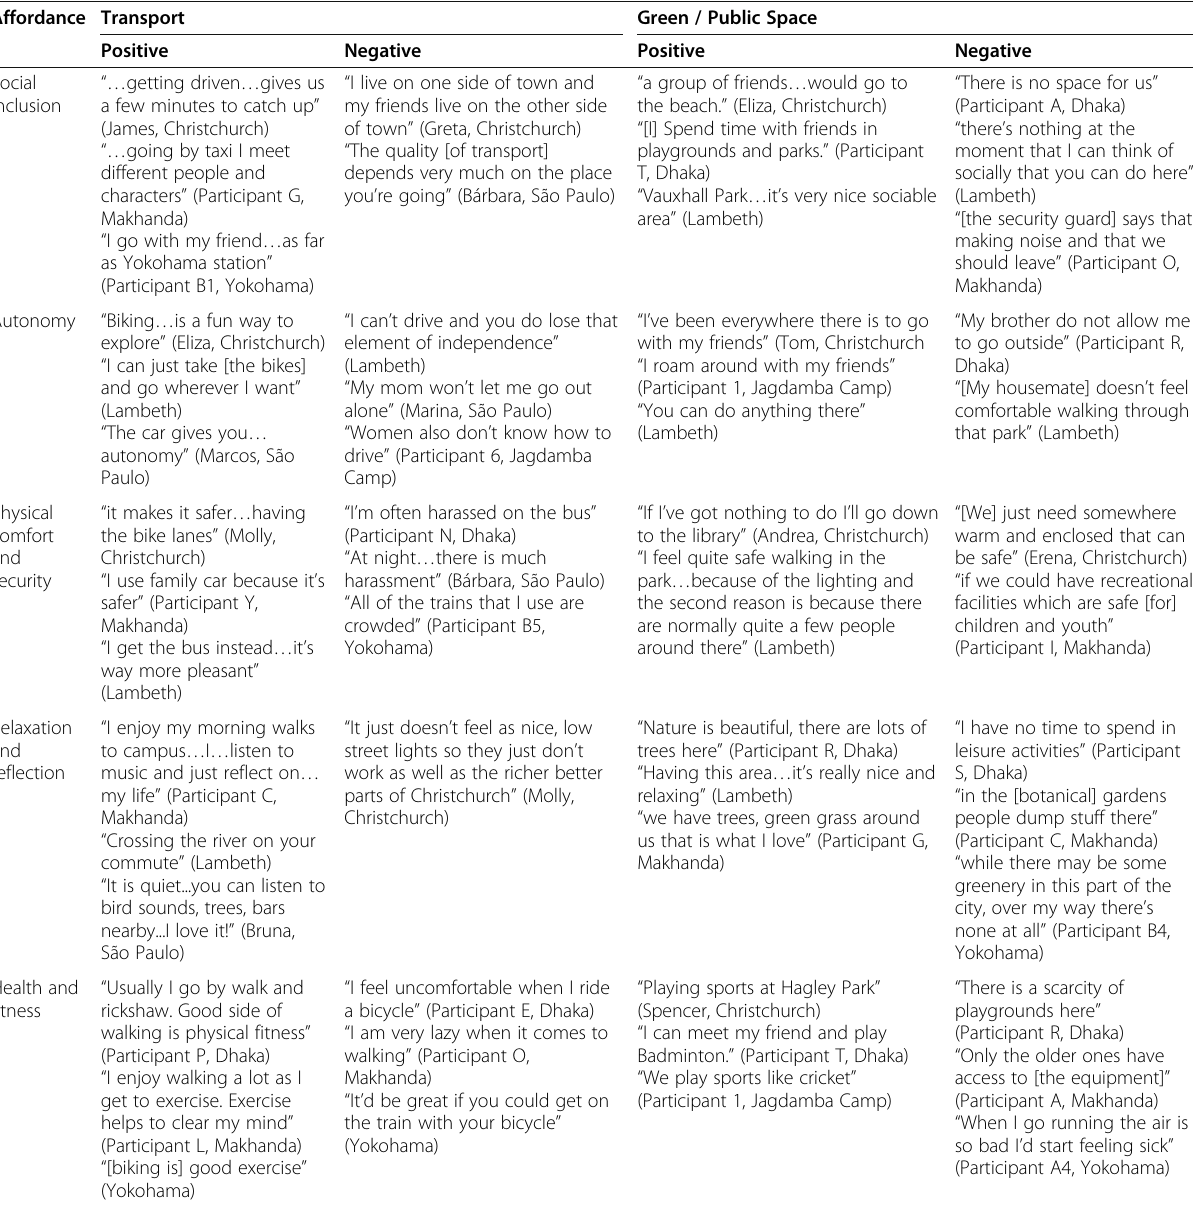
Table 2 Extracts summarising the affordances young people described in relation to transport and green and public space Affordance Transport Green / Public